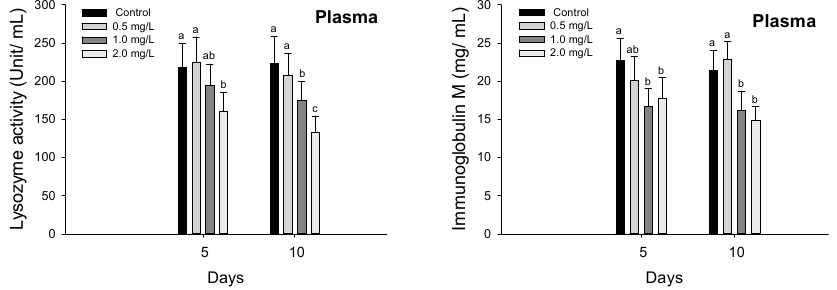
Figure 5. Immune responses of flatfish, Paralichthys olivaceus exposed to the different concentrations of waterborne chromium for 10 days. Values with different superscripts are significantly different in 5 and 10 days ( p < 0.05) as determined by Tukey’s multiple range test.